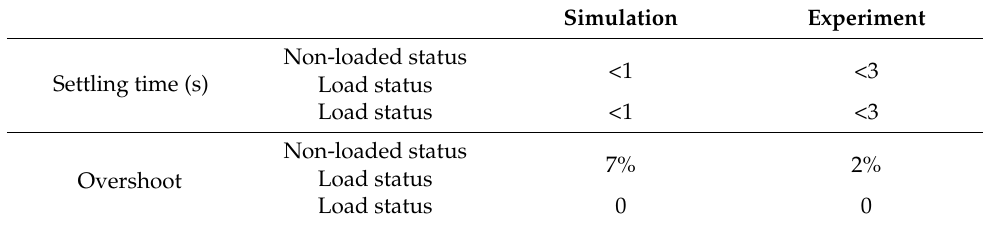
Table 5. The basic parameters of the motor during the